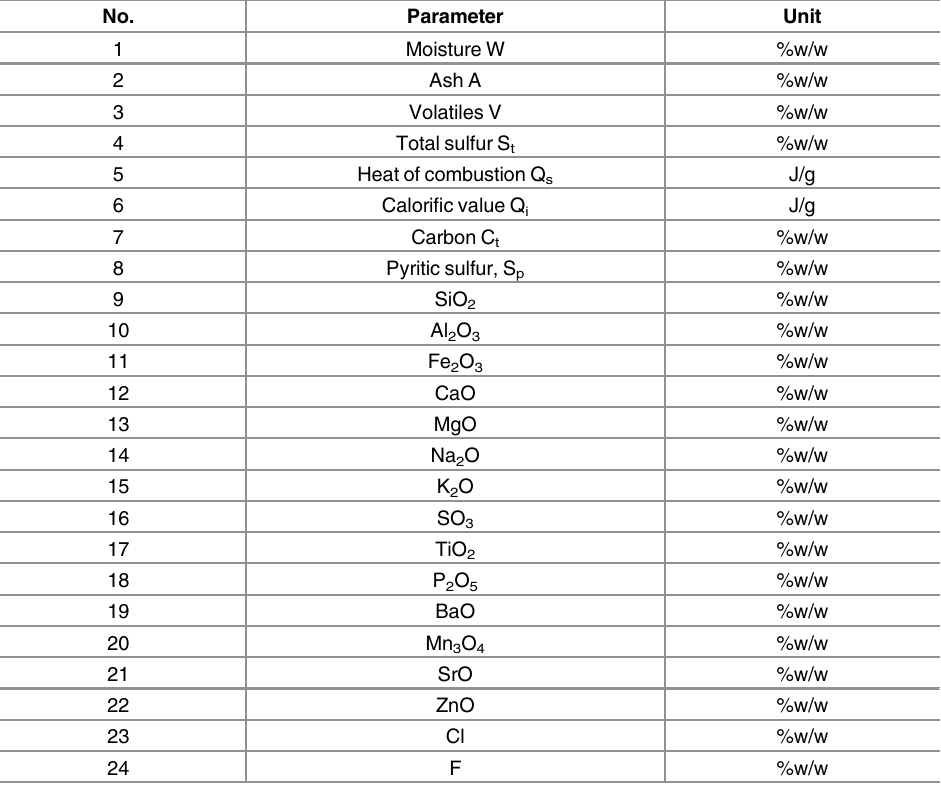
No. Parameter Unit 1 Moisture W %w/w 2 Ash A %w/w 3 Volatiles V %w/w 4 Total sulfur S t %w/w 5 Heat of combustion Q s J/g 6 Calori fi c value Q i J/g 7 Carbon C t %w/w 8 Pyritic sulfur, S p %w/w 9 SiO 2 %w/w Al 2 O 3 %w/w Fe 2 O